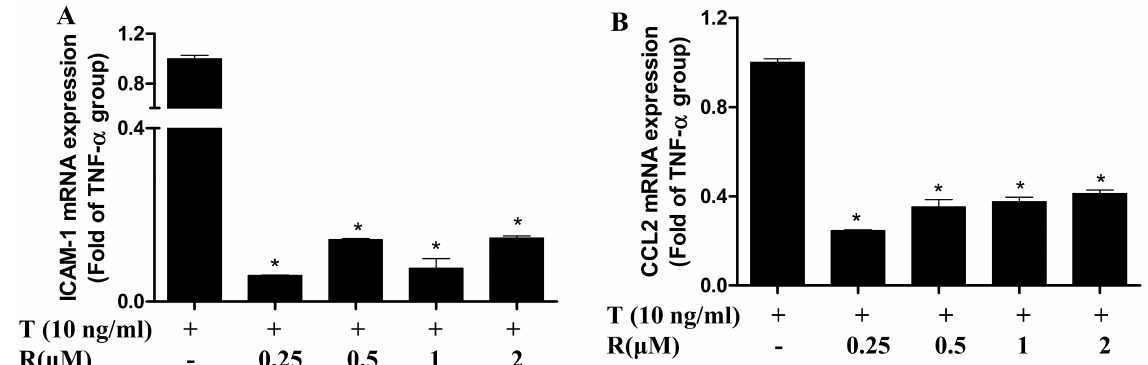
Figure 2. Resveratrol reduced the expression of ICAM-1 ( A ) and CCL2 ( B ) in ECs. EA.hy926 cells were pretreated with various concentrations of resveratrol (R) for 1 h prior to the addition of TNF- α (T, 10 ng/mL) for 1 h in the continued presence or absence of resveratrol. The relative mRNA abundances of ICAM-1 and CCL2 were determined by real-time PCR and mean quantities were normalized based on the mean of housekeeping gene GAPDH. T, TNF- α ; R, Resveratrol. Values represent mean ± SEM, n = 3. *, p < 0.05 vs. control; *, p < 0.05 vs. TNF- α -alone-treated cells. CCL2/MCP-1, monocyte chemoattractant protein-1; ICAM-1, soluble intercellular adhesion